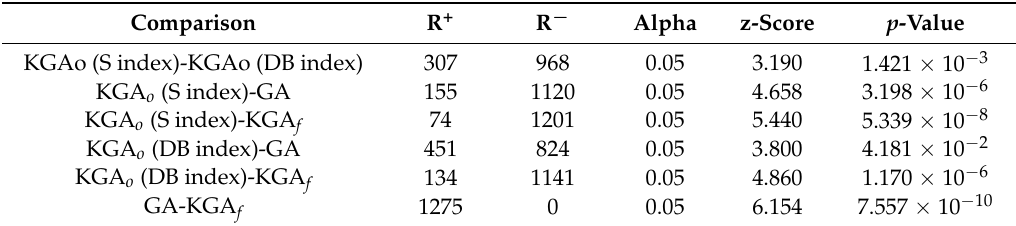
Table 4. p -Values for the Wilcoxon test in paired comparisons for test number